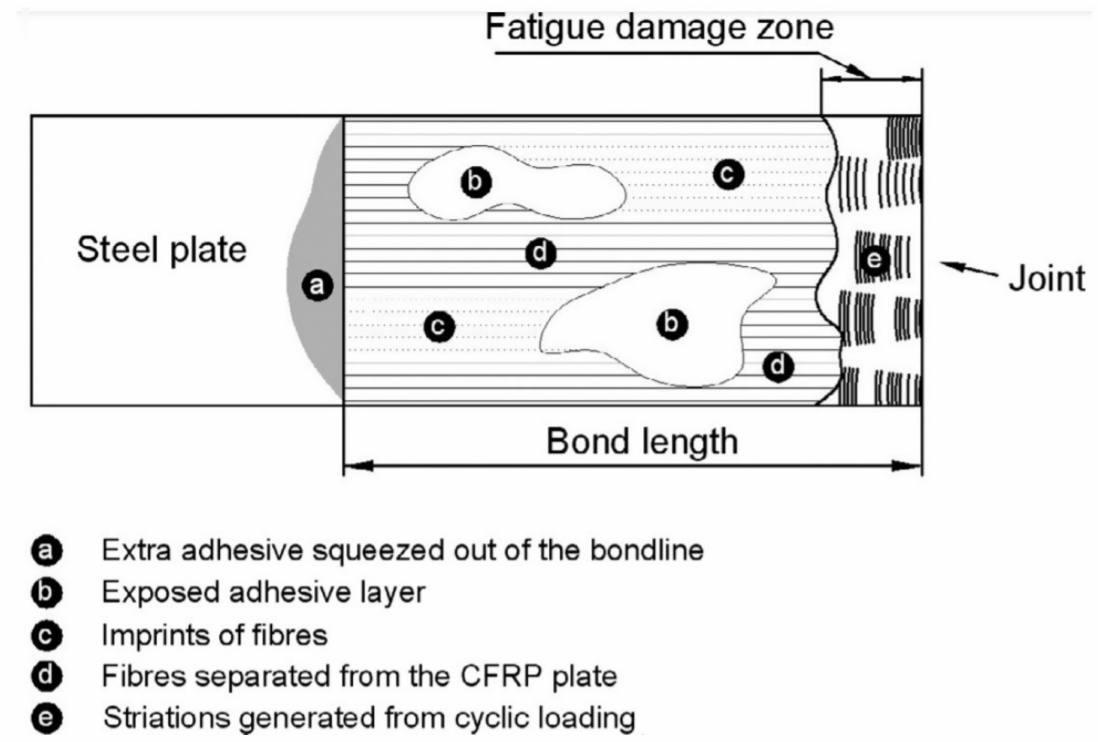
Figure 5. Microscopic scan locations on the fracture surface of the failed specimens and illustration of “fatigue damage zone” [68]; used with permission from Composites Part B: Engineering, Elsevier,